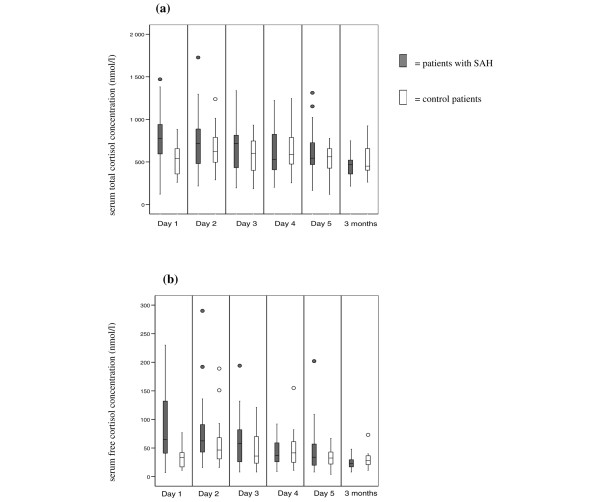
Serum free and total cortisol concentrations. Patients with subarchnoid haemorrhage (SAH) had higher initial (a) serum total cortisol (p = 0.001) and (b) free cortisol concentrations (p < 0.001) than control patients. At later time points, there were no differences between the groups in this respect. Data are presented as median, interquartile ranges and outliers.